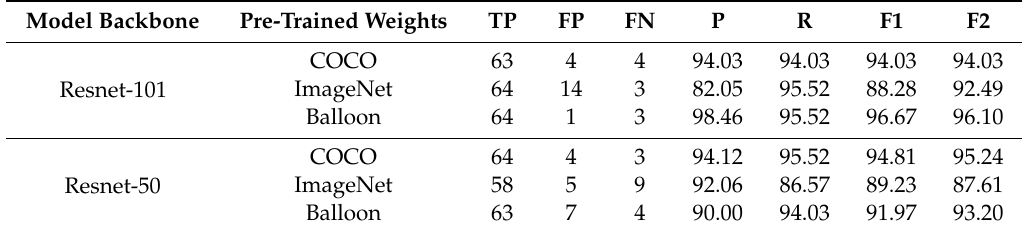
Table 7. Results from testing on the Mayo Clinic wireless capsule endoscopy (WCE) polyp data. Model Backbone